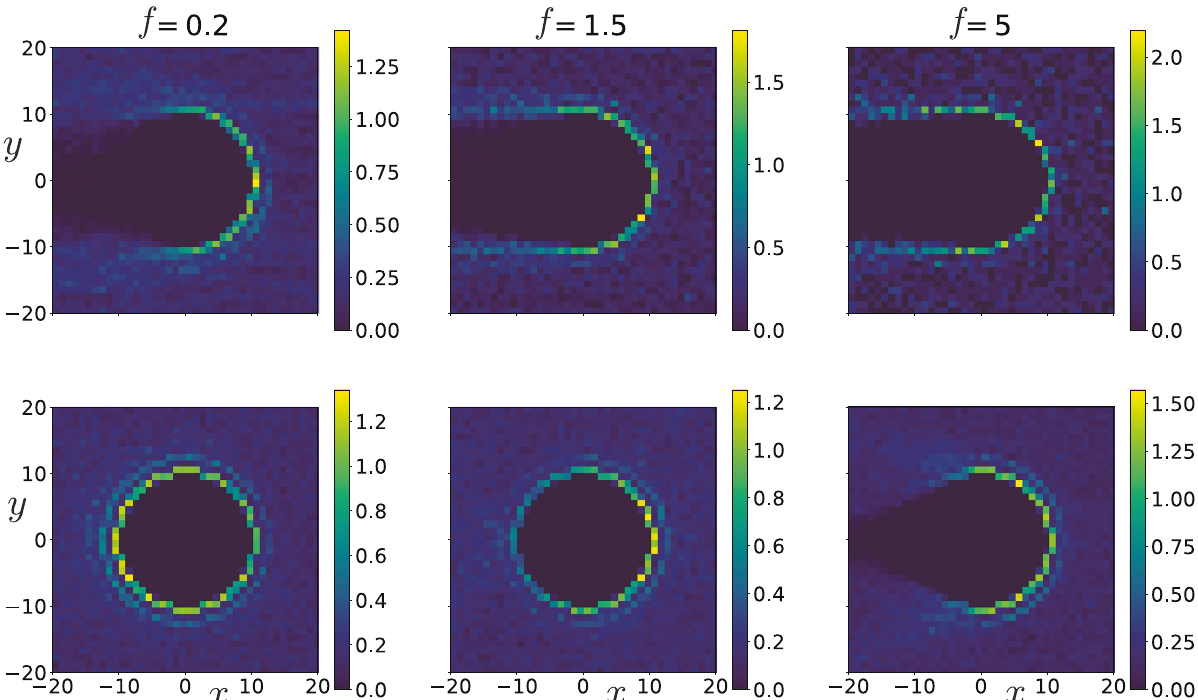
Figure 3. Average density (in units of σ − 2 ) of disks around the tracer in a passive bath (top row), and in an 80 (bottom row) for three different external force values f active bath with Pe = and active bath settings, the force scale of the active bath is used to define the rescaled force f